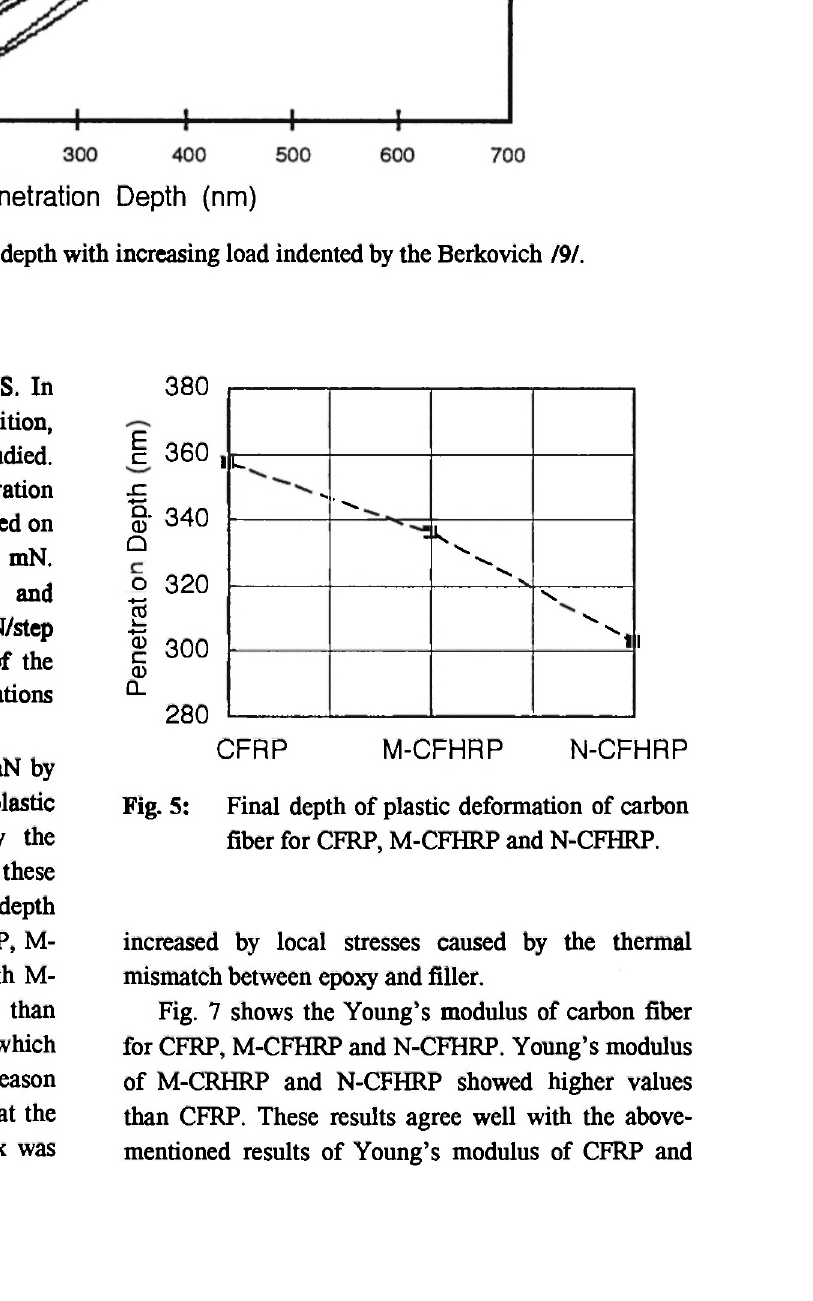
increased by local stresses caused by the thermal mismatch between epoxy and